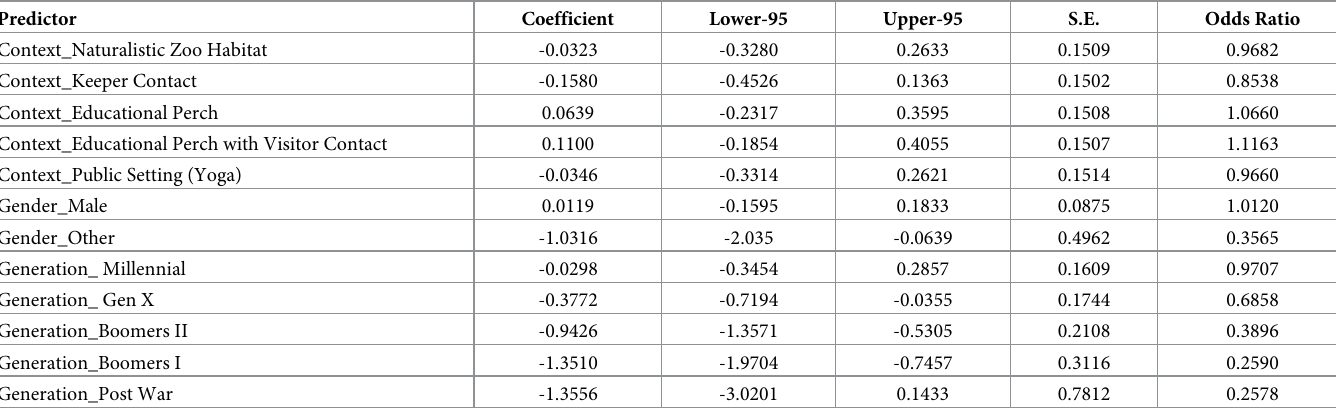
Table 3. Ordinal logistic regression results for the sloth experiment. Predictor